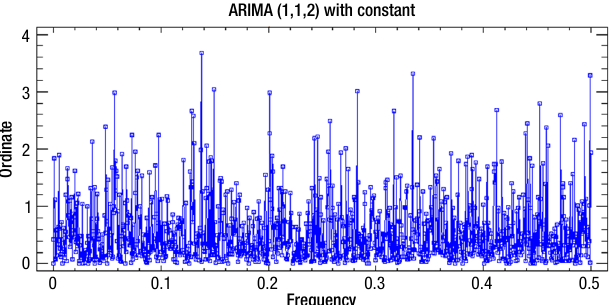
Fig. 6. Residual periodogram for adjusted time series of Overnight 2000–2008